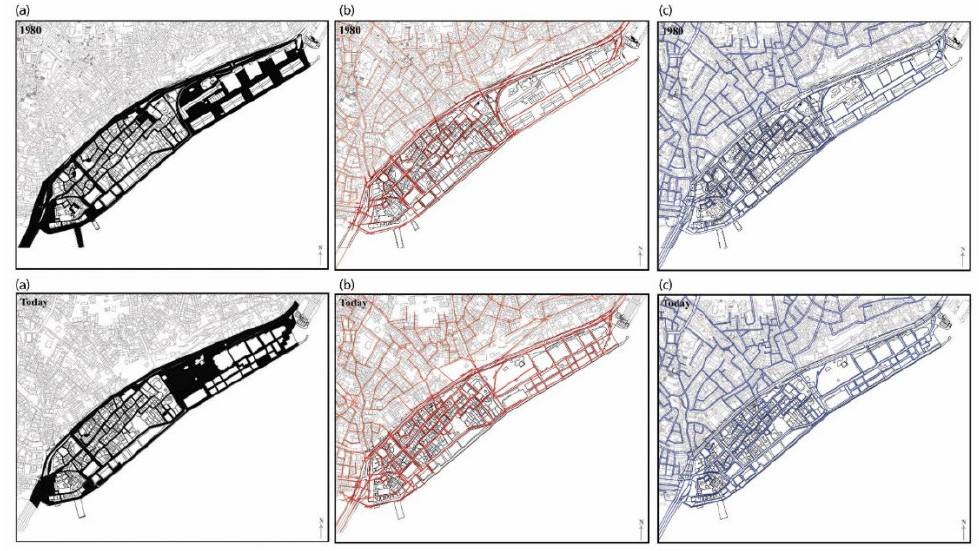
Figure 14 Maps of the area in 1980 (top) and today (bottom): (a) open space map (shown in black); (b) transcription of the plan into the convex map; (c) transcription of the map into an axial map, prepared by the